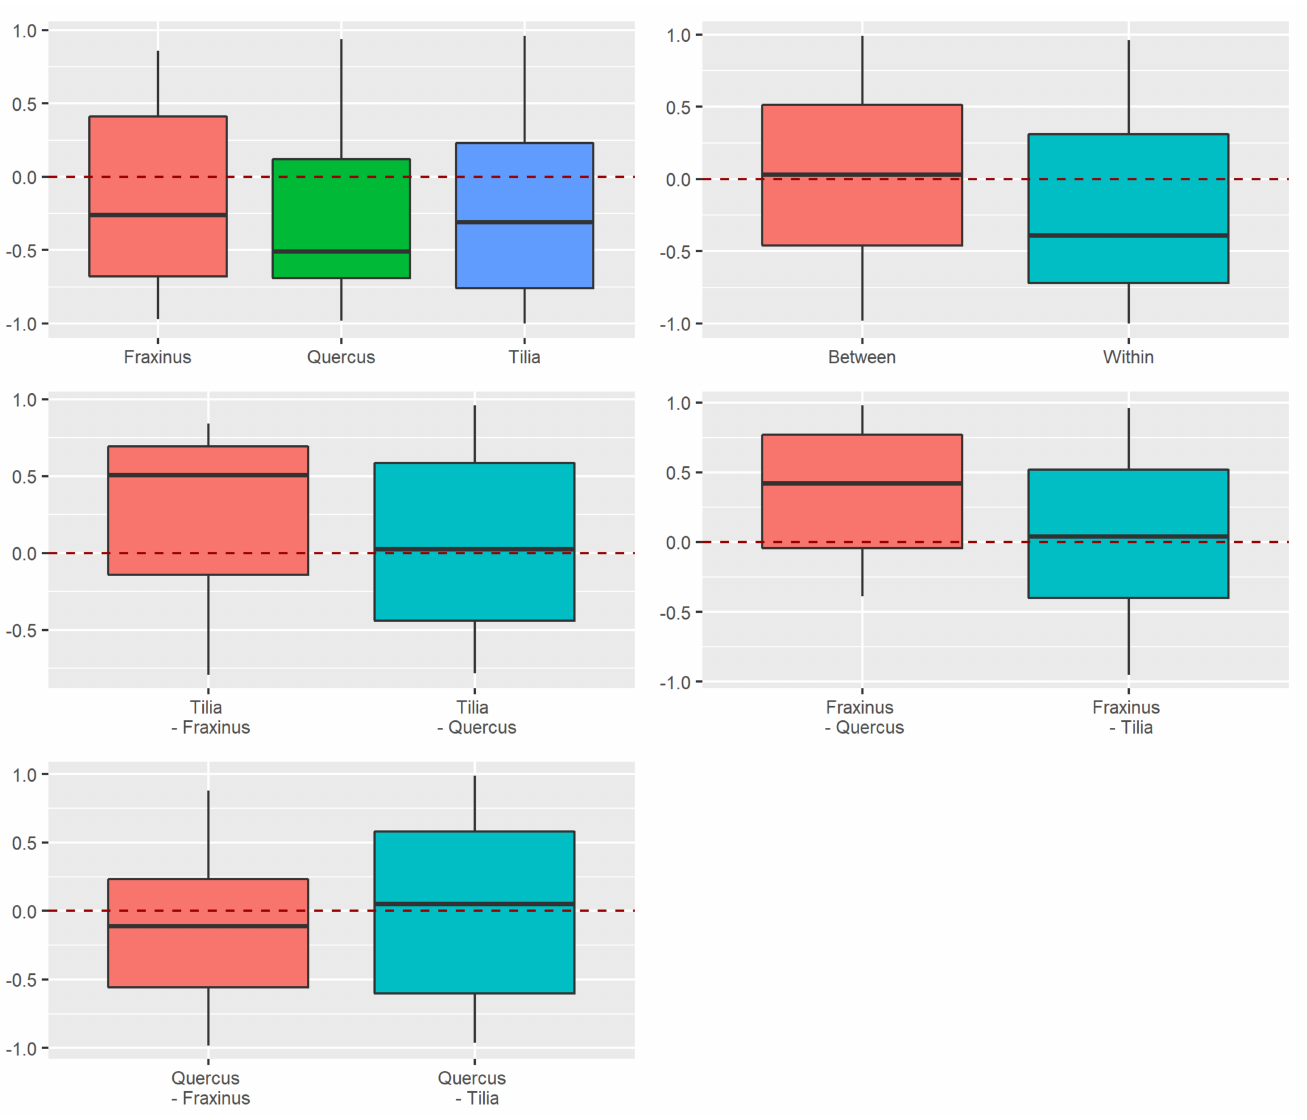
Figure A12. Deviation of the beta diversity from the diversity expected by the null hypothesis per tree species for the rare beetle species, rarity classification according to the octaves. Comparisons within a tree species are comparisons of two traps of the same tree species. Comparisons between tree species are comparisons of two traps from two different tree